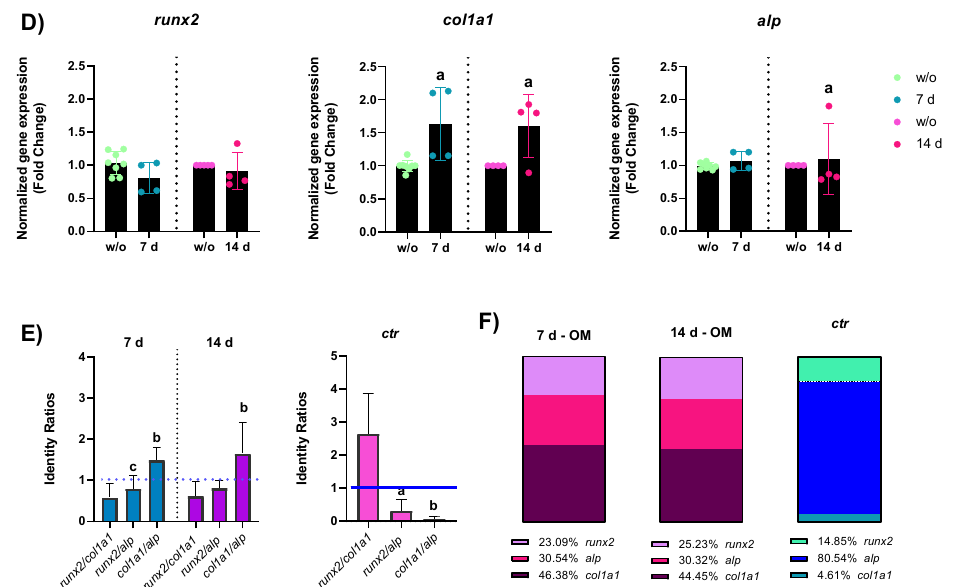
Figure 3. Gene expression results of hASCs cultured both in GM and OM with or w/o the PEMF treatment for 7 and 14 days. The results shown in panels ( A – C ) refer to treated and untreated (PEMFs+ and w/o) hASCs kept in GM, whereas the panels ( D – F ) show the results of PEMFs+ and w/o hASCs committed towards the osteogenic differentiation (OM). The gene expression results in the bar plots ( A , D ) are reported as the mean ± S.E.M. of fold changes (FC). The results in ( B , E ) are the identity ratios of treated and untreated hASCs expressed in the plots as the mean ± S.E.M. of FC ratios. Finally, in ( C , F ) are reported “part of whole” plots, which highlight the proportion of bone-specific genes (expressed as FC) of treated and untreated hASCs. The bold letters a, b and c in the plots indicate the statistically significant results ( p < 0.05). In ( A , D ), the data were analyzed with an unpaired t -test: w/o vs. PEMFs+. In ( B , E ), the identity ratios were tested with a One-Way ANOVA followed by Tukey’s test for multiple comparison: a—runx2/col1a1 vs. col1a1/alp; b—runx2/col1a1 vs. col1a1/alp; c—runx2/alp vs. col1a1/alp. All the results reported are the mean ± S.E.M. of six independent experiments, tested for normality and further analyzed with GraphPad Prism 8.4.2.